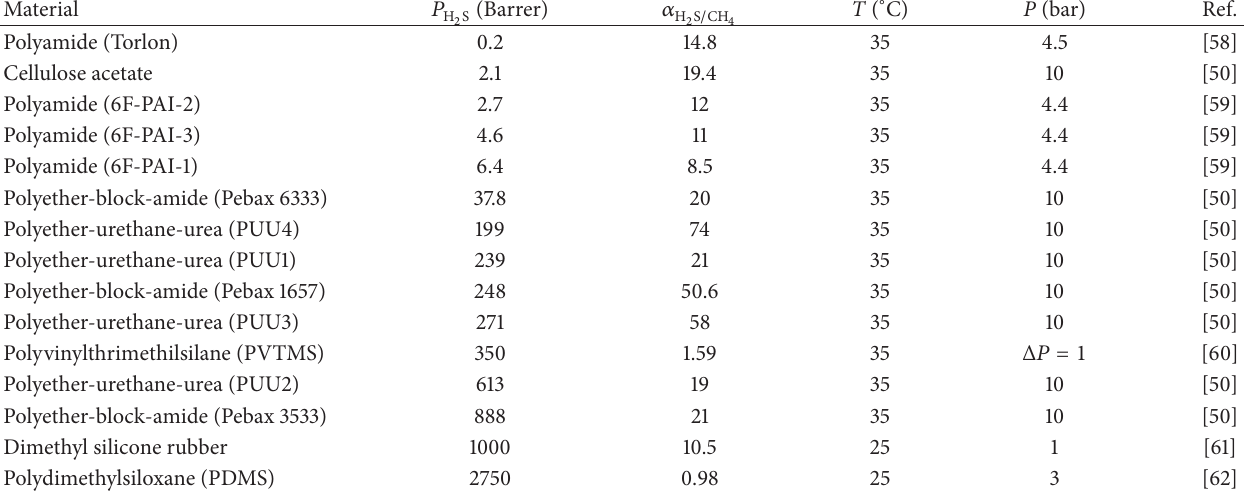
Table 2: Permeability and selectivity of different polymeric membranes for removal of hydrogen sulfide from natural gas.